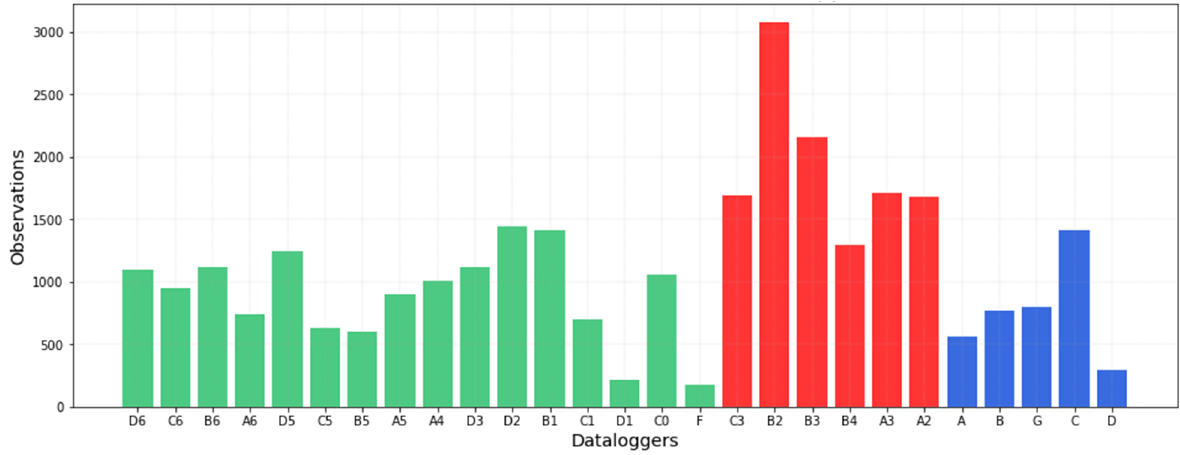
Sensors 2021 , 21 , x FOR PEER REVIEW 17 of 21